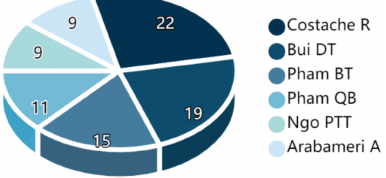
Figure 3. Distribution diagram of core